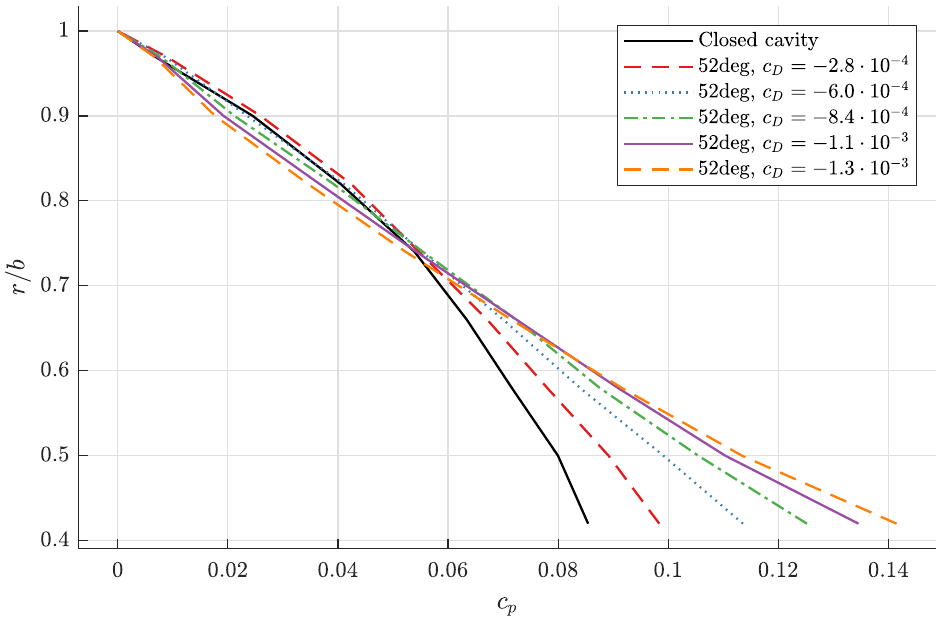
Figure 9. Measured radial pressure distribution at the relative cavity width of G = 0.0125 and in the Reynolds number range of 7.5 centripetal through-flow at the preswirl angle of